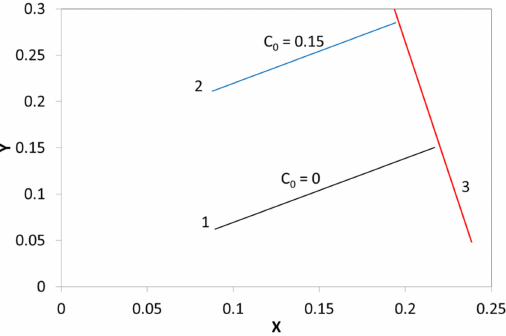
Figure 8. Data for model (13) and constants C = 0.69 and C o = 0 and 0.15 after transformation acc. (14) from locus (23) for 0.1 ≤ x g ≤ 0.5, ρ o = 1300 kg/m 3 . 1—acc. (13), ρ = π ρ ∗ = 784.02 kg/m 3 . 2—acc. (26), ρ = π Equation (23).